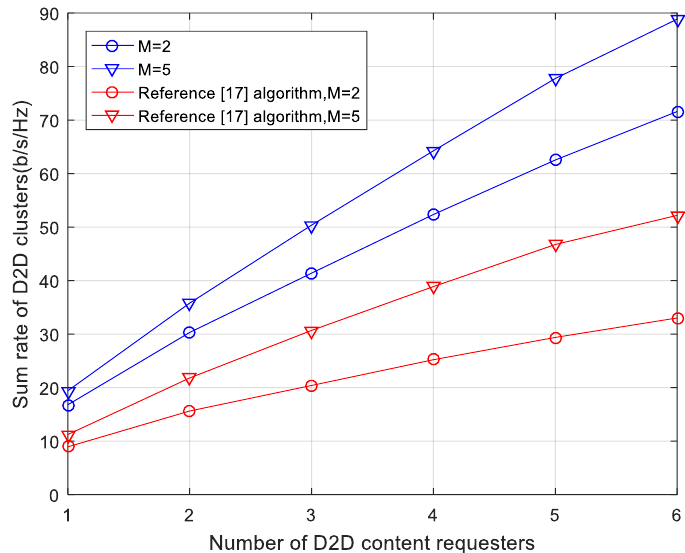
Figure 8. Sum rate of D2D clusters for di ff erent numbers of cellular channels with di ff erent numbers of D2D content requesters, K = 2 0 0 .